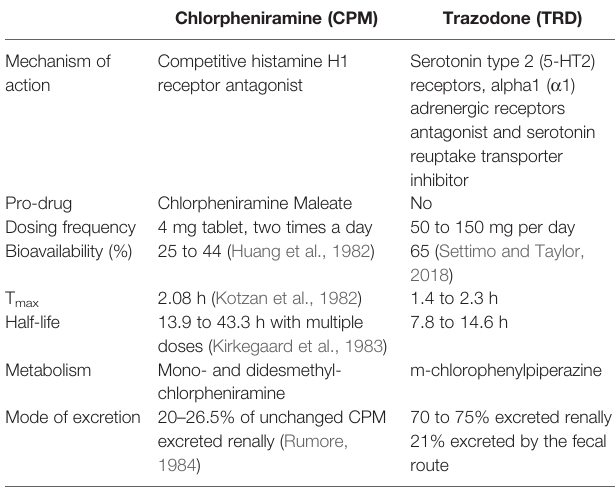
TABLE 2 | Pharmacokinetic and Pharmacodynamics properties of CPM and